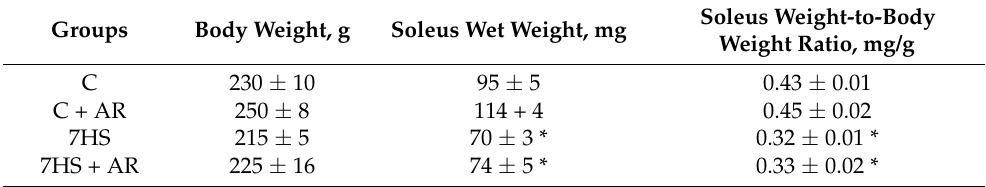
Table 1. Changes in body weight, soleus wet weight and soleus weight-to-body weight ratio.